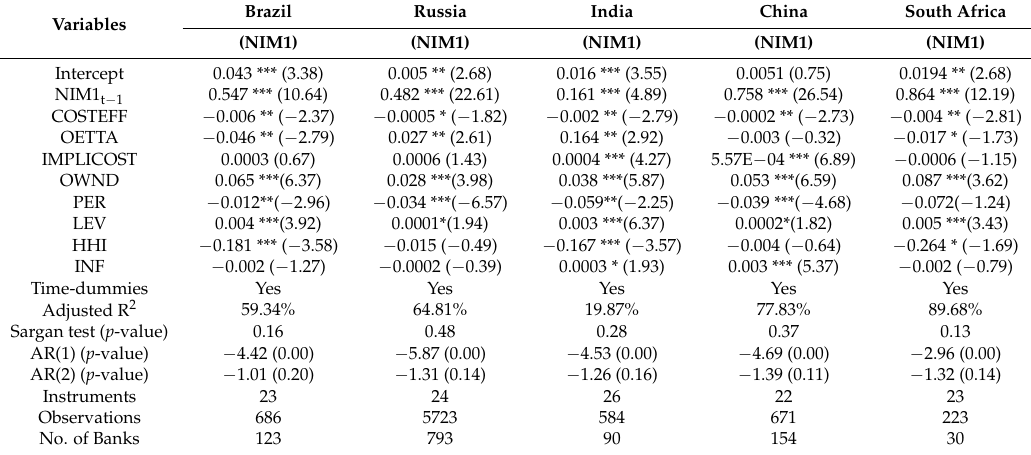
Table 9. Impact of Cost Efficiency on the Banks’ Cost of Financial Intermediation (Country-Wise